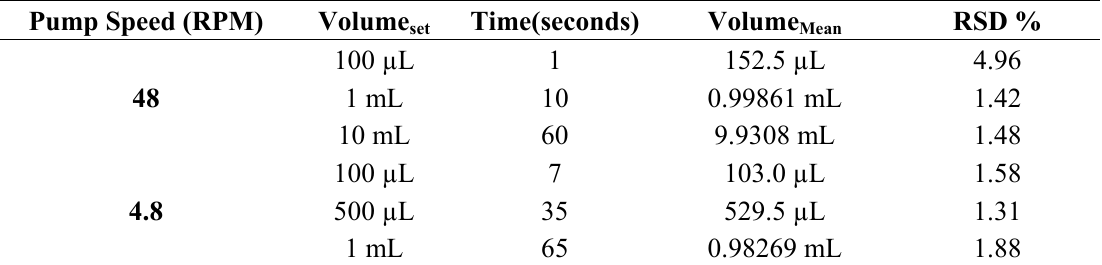
Table 1. MCFA system repeatability obtained for two different speeds and four different